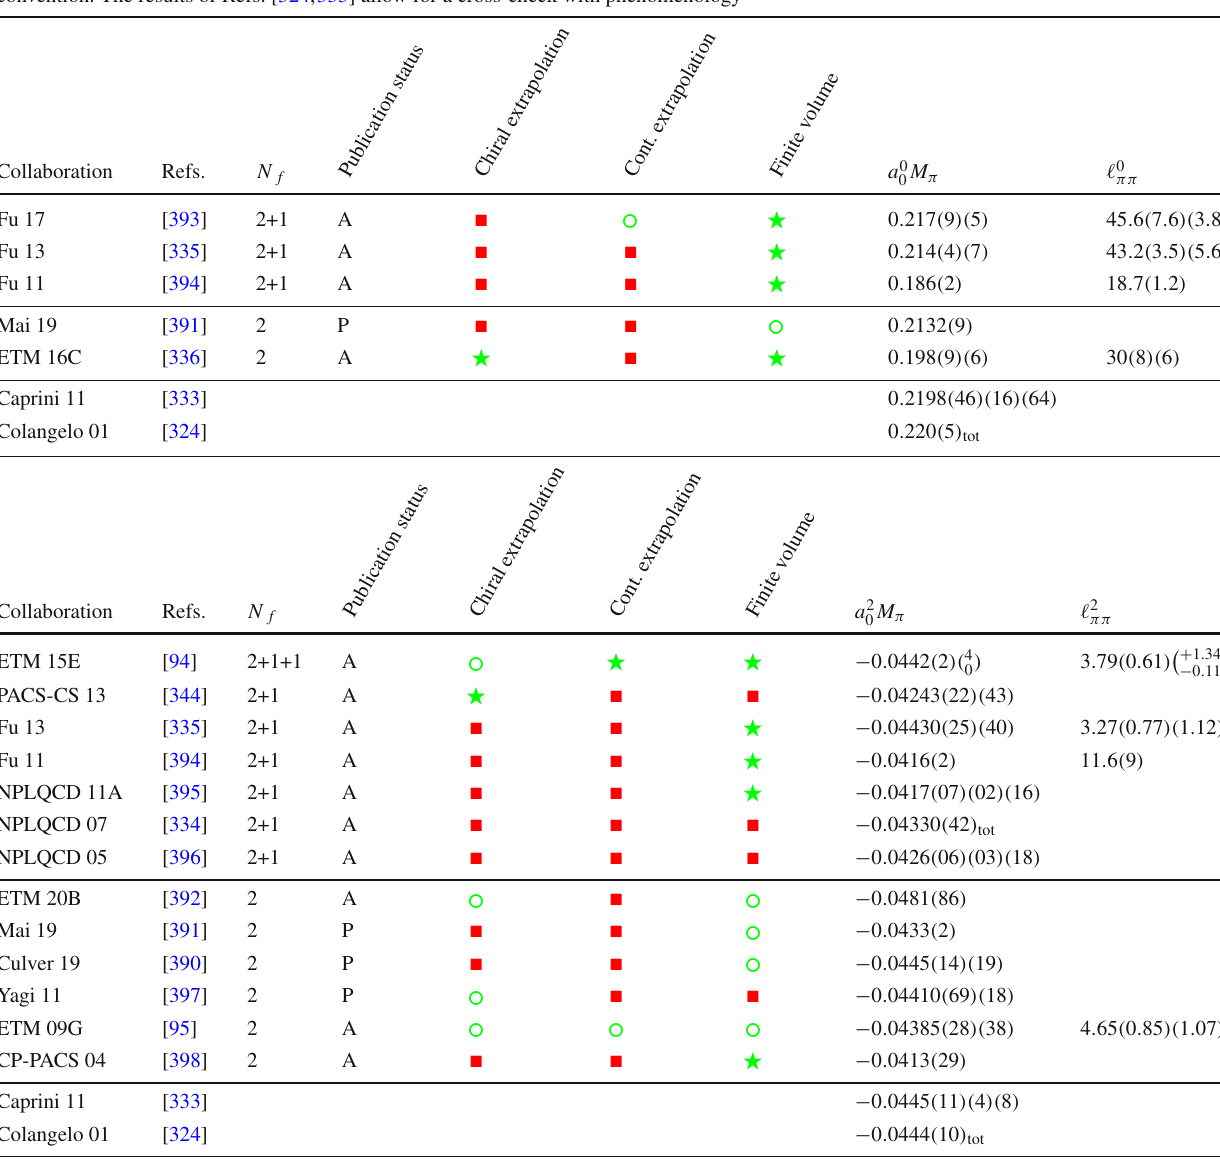
Table 25 Summary of ππ scattering data in the I = 0 (top) and I = 2 (bottom) channels. Some of the results have been adapted to our sign convention. The results of Refs. [324,333] allow for a cross-check with phenomenology